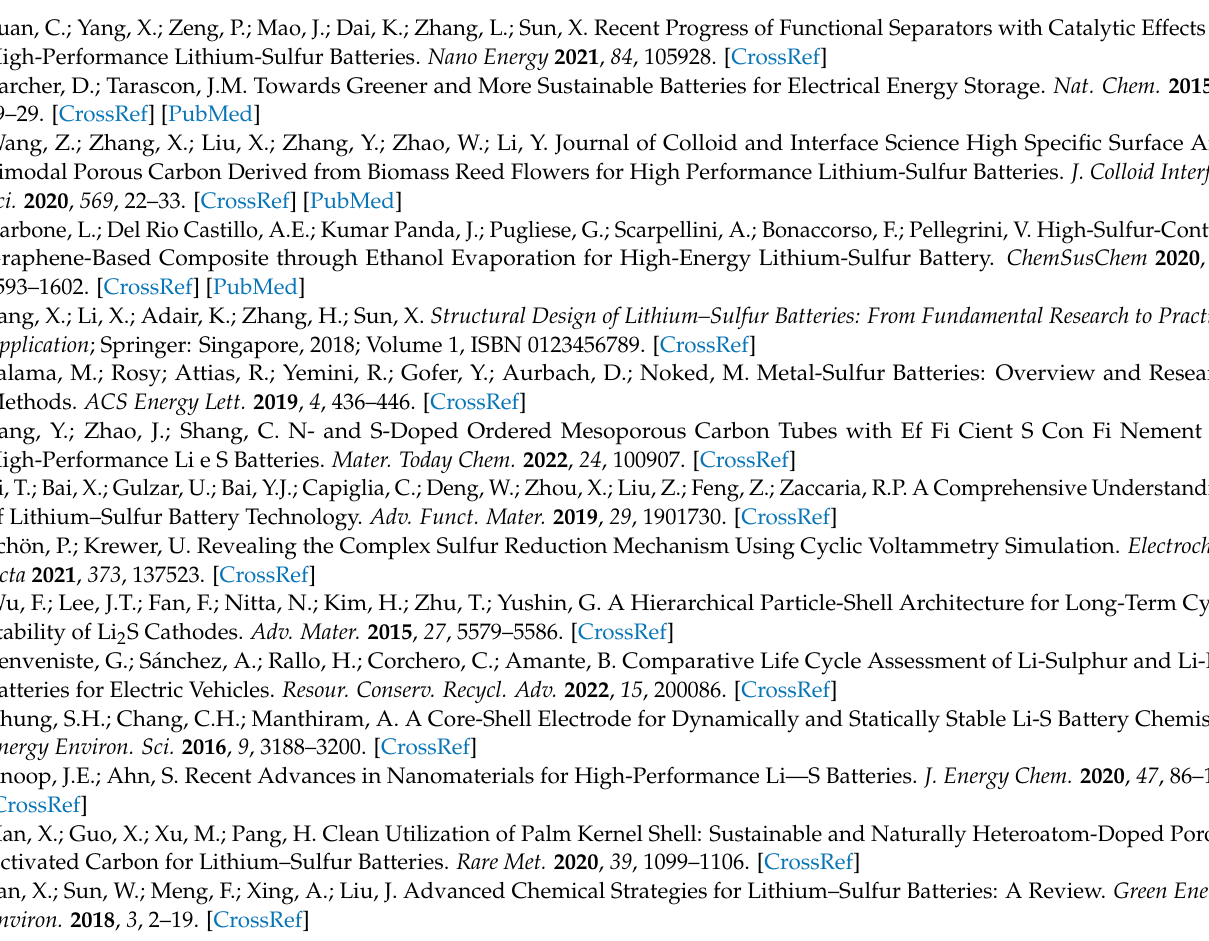
Figure 4c of the S80SWCNH20 electrode for different states of charge; Figure S3: Voltage profiles